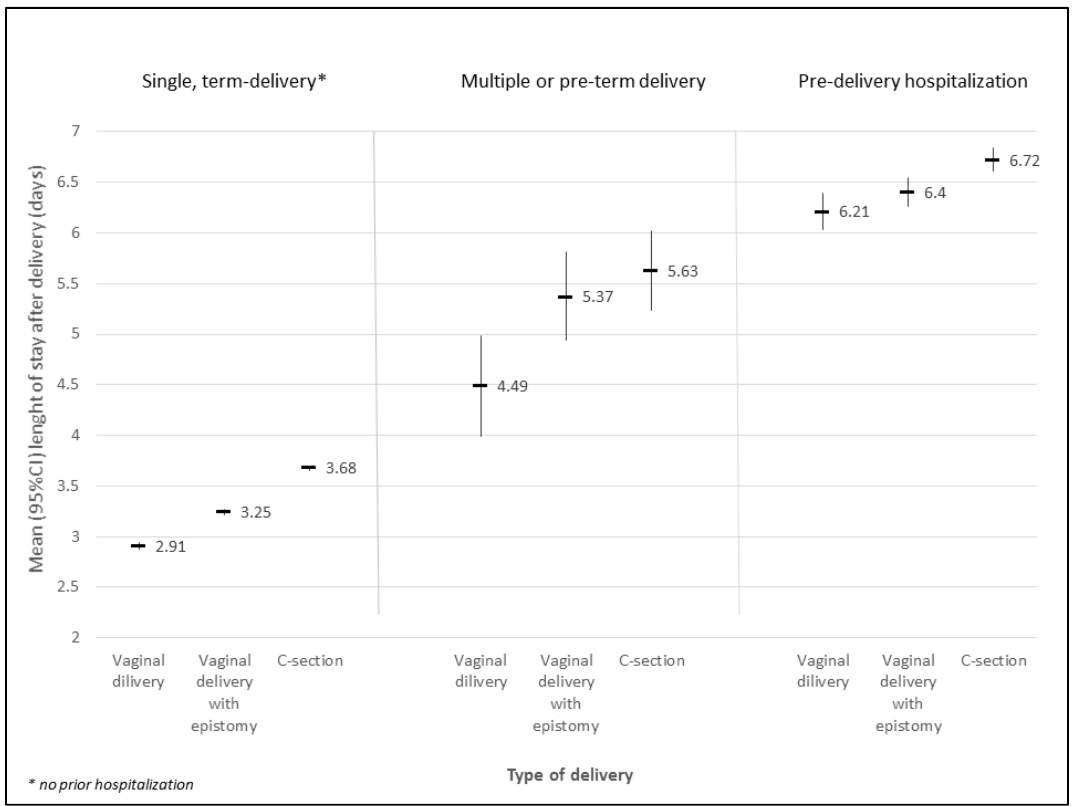
Figure 1. Length of stay in the hospital after birth (days) in the years 2013–2014 in the Malopolska province in respect of mode of admission for the delivery and type of birth (ANOVA results: admission mode F(2, 67908) = 5488.7; p < 0.001; type of birth F(2, 67908) = 66.9; p < 0.001; and interaction effect F(4, 67908) = 4.51; p = 0.001).